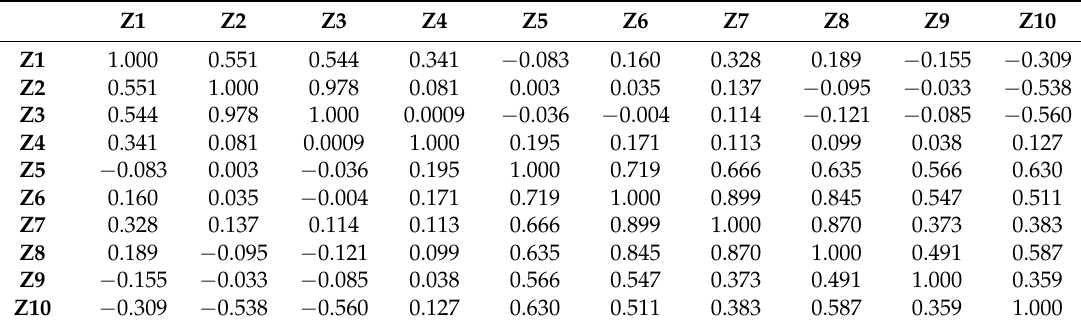
Table 4. Pearson correlation coefficients for variables related to removal